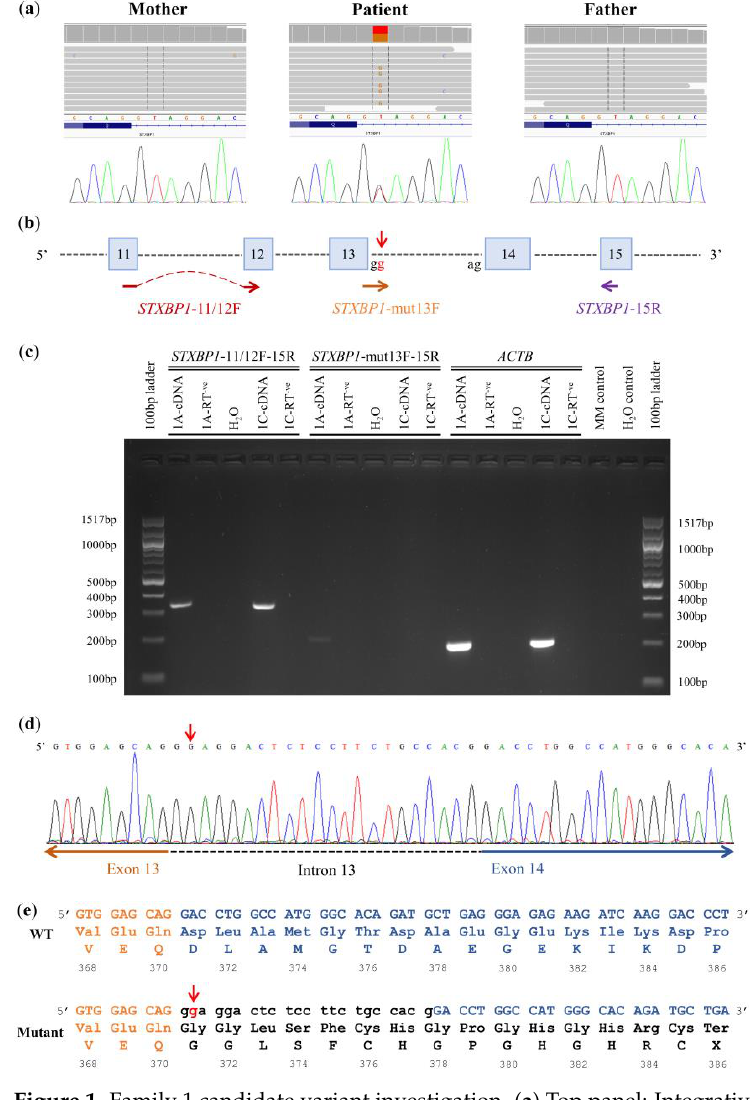
Figure 1. Family 1 candidate variant investigation. ( a ) Top panel: Integrative Genomics Viewer (IGV) screenshots of the genomic region overlapping the patient-specific STXBP1 splice donor variant. Lower panel: Sanger sequencing confirming that the patient was heterozygous for the mutated allele (T/G), while both parents are homozygous for the reference allele (T/T). ( b ) Schematic representation of the STXBP1 gene (exons 11–15) and reverse-transcription PCR (RT-PCR) primers used in this study: primer STXBP1 -11/12F spans two consecutive exons to ensure that only cDNA will be amplified, primer STXBP1 -15R maps downstream the splice-site variant on the proximal end of exon 15, while primer STXBP1 -mut13F specifically amplifies the mutated allele (vertical red arrow). ( c ) Agarose gel electrophoresis of RT-PCR amplicons from the patient (sample 1A) and his non- affected father (sample 1C). The integrity of the cDNA samples is tested by amplification of an ACTB gene fragment. RNA samples not reverse transcribed (RT-ve) and no template (H 2 O) samples are used as negative controls to detect any contaminating DNA. A master mix (MM) control is also included. ( d ) Impact of the NM_003165.6:c.1110+2T>G variant (red vertical arrow) at the RNA level; twenty-two intron 13 nucleotides are inserted between exons 13 and 14 in the mature mRNA of the patient. ( e ) Predicted impact of the NM_003165.6:c.1110+2T>G variant (red vertical arrow) at the protein level; fifteen new amino acids are included followed by a premature termination codon. Nucleotides from exon 13 and 14 sequences are presented in orange and blue, respectively, while intron 13 sequences are shown in black lower-case letters. Numbers correspond to amino acid positions according to NP_003156.1.